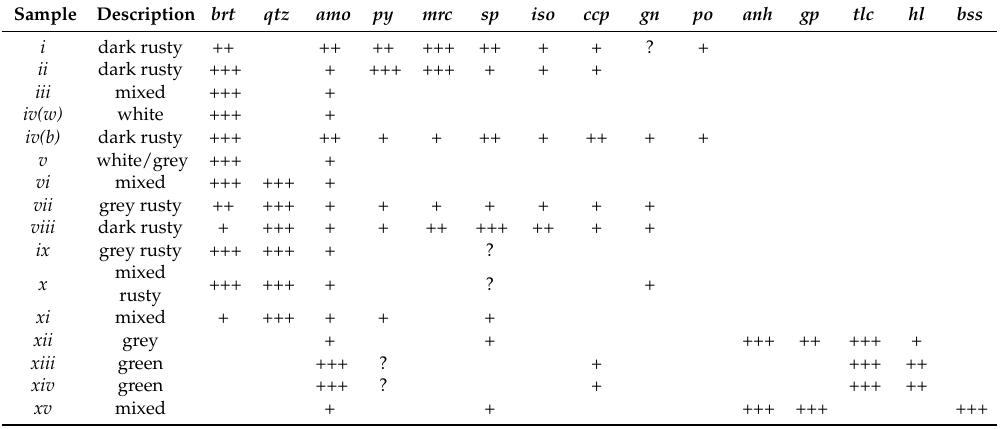
Table 1. Mineralogy of samples after XRD analysis. ? is uncertain, + is 0–5%, ++ is 5–15%, +++ is 15% and over. Mineral abbreviations after [43]. amo is amorphous phase; iso is isocubanite. Sample Description brt